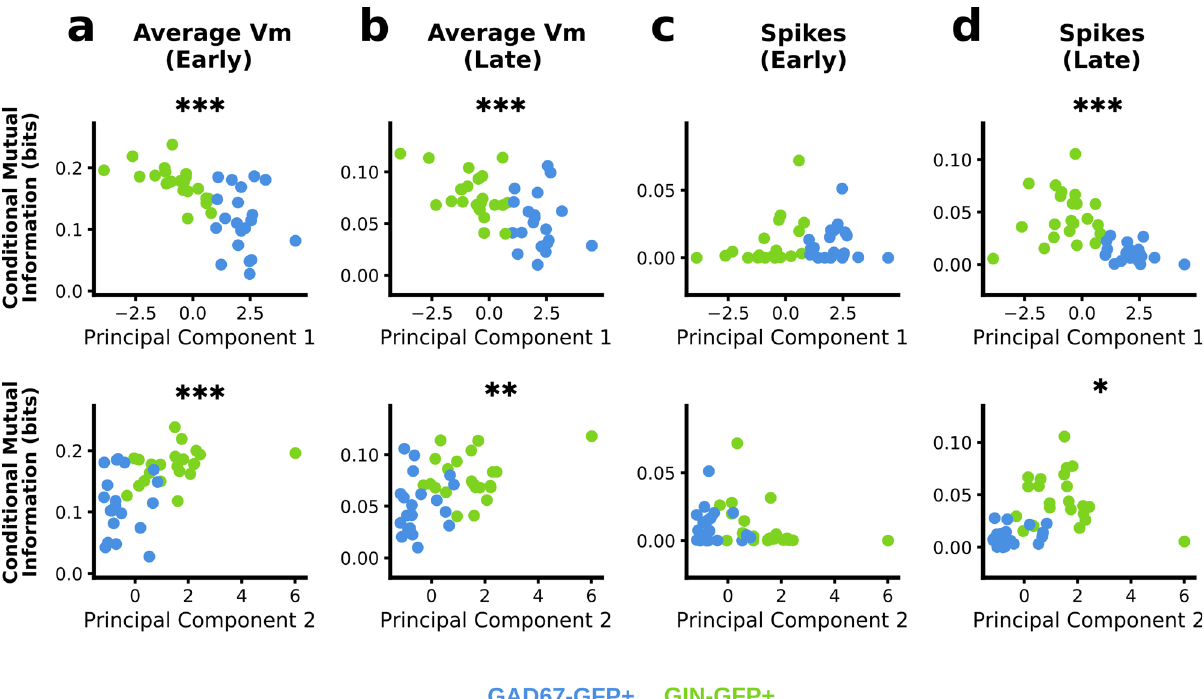
Fig. 9 Conditional mutual information between responses in recorded neurons and rate code correlates with fi rst and second components of electrophysiological features in GAD67 + and GIN + interneurons. a Conditional mutual information between average membrane potential and 1-bit rate coded signal correlated with fi rst and second principal components (PC1 and PC2, respectively) of electrophysiological features in the early window (PC1: Pearson ’ s r = − 0.65, p ≤ 0.001; PC2: Pearson ’ s r = 0.52; p ≤ 0.001). b Same as ( a ) but comparing later average membrane